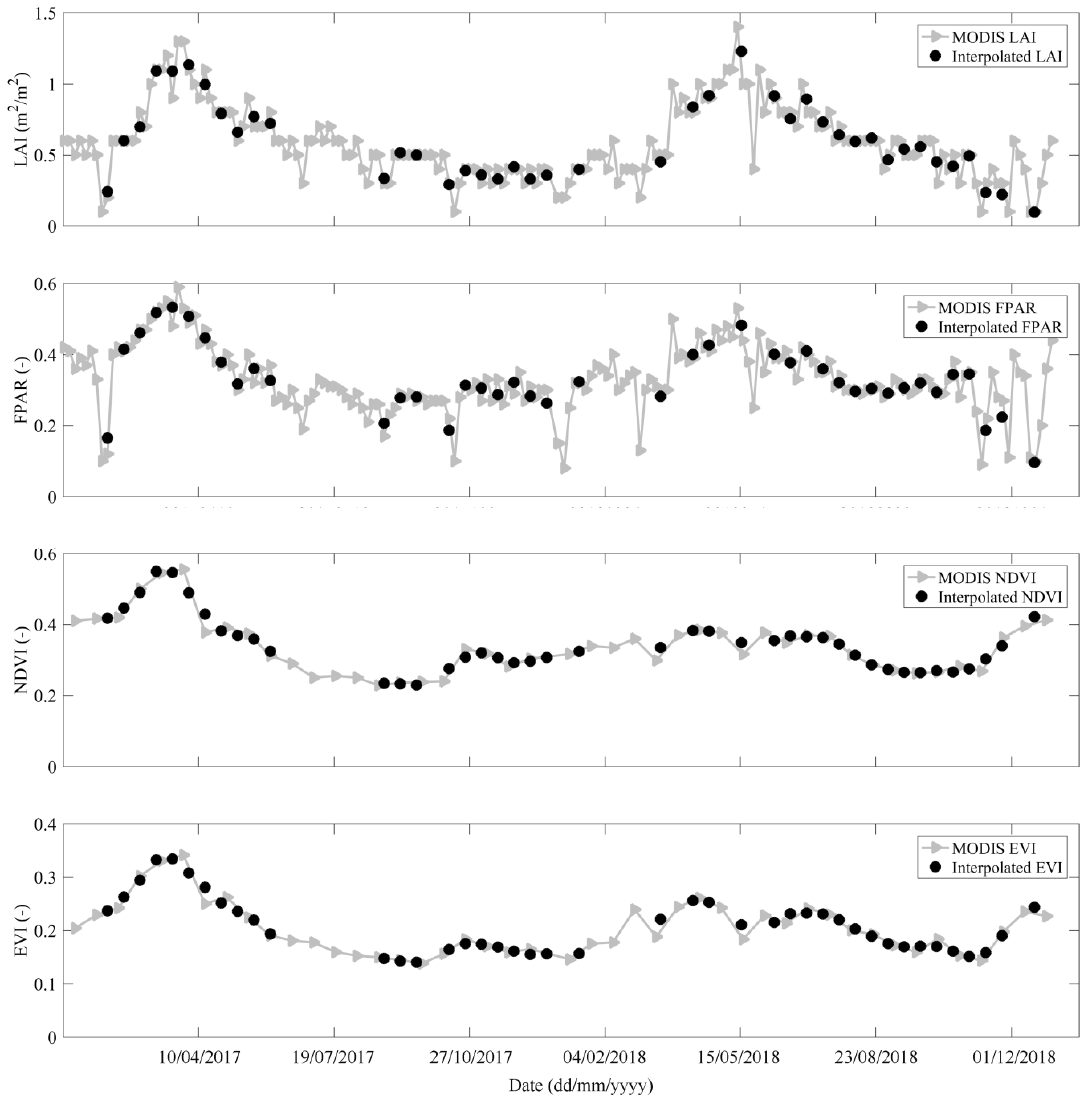
Figure 3. Time series of the Moderate Resolution Imaging Spectroradiometer (MODIS) original vegetation parameters and their interpolated values from the station Las Bodegas. The LAI, FPAR, NDVI, and EVI stand for the leaf area index, fraction of photosynthetically active radiation, normalized difference vegetation index, and enhanced vegetation index, respectively.